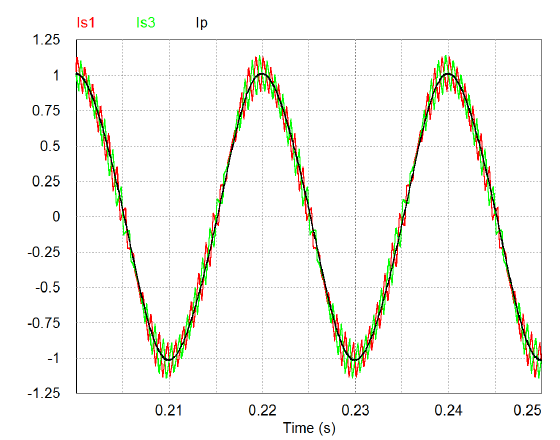
Figure 12. Two secondary currents and the primary current in normal operation mode. Traces: Is1 - AC current of converter 1, Is3 - AC current of converter 3, Ip - primary current.